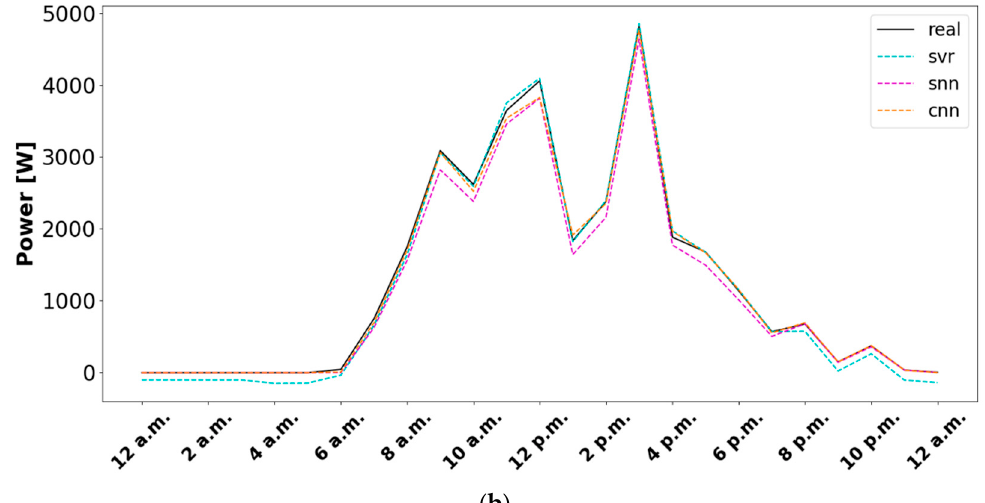
Figure 6. Adjustments corresponding to the train split of the SVR, SNN and CNN models in the forecast of photovoltaic production: ( a ) Forecast on a day with good conditions, ( b ) Forecast on a day with variant conditions.